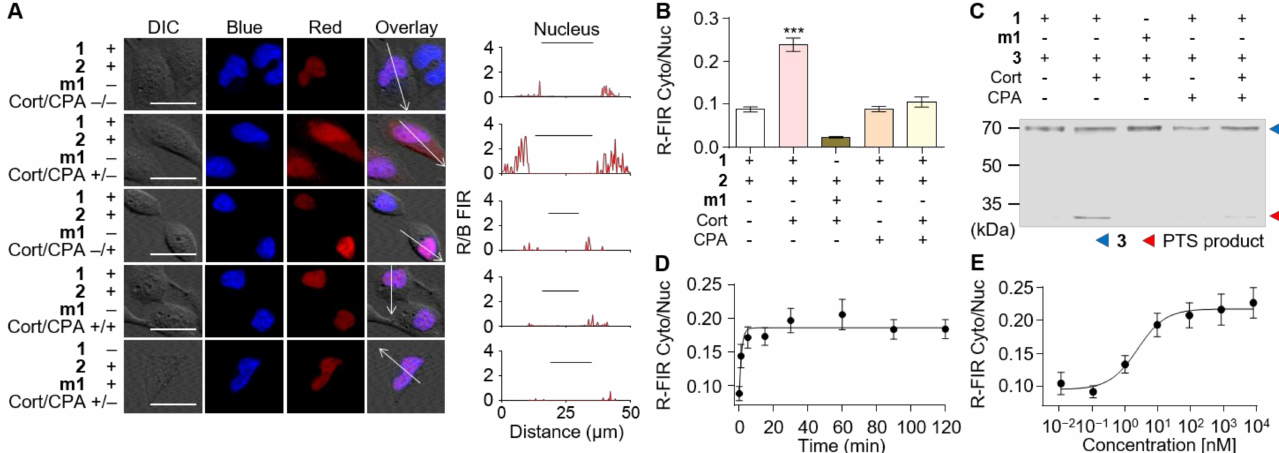
Figure 2. Detection of cortisol (Cort) stimulation using sensor cells based on the conditional protein splicing reaction and performance evaluation of sensor cells. ( A ) The sensor cells co-expressing proteins 1 and 2 show red fluorescence in the nucleus before stimulation (row 1), and the fluorescence signal translocates to the cytosol when sensor cells are challenged with Cort (row 2), the GR antagonist, cyproterone acetate (CPA), did not induce signal translocation (row 3) and instead inhibited Cort-mediated signal translocation (row 4), mock sensor cells containing fusion proteins m1 and 2 did not show fluorescence translocation when challenged with Cort (row 5, scale bar = 25 µ m); ( B ) the red fluorescence intensity ratios from the cytoplasm to nucleus (R-FIR Cyto/Nuc) are calculated, data were analyzed using one-way ANOVA using the Tukey multiple comparison test (*** p < 0.001); ( C ) the Western blot analysis showed the formation of CPS product in the presence of target from the sensor cells, suggesting covalent conjugation of the split-signal peptide; ( D ) the time-response curve demonstrates the sensor responses as early as 1 min after Cort stimulation, and R-FIR Cyto/Nuc plateaued approximately at 10 min; ( E ) dose-response fluorescence intensity curve showing the increase in the fluorescence intensity ratio with increasing Cort concentration, the limit of detection was 3.5